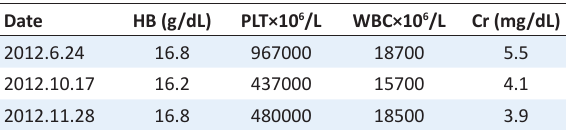
Table 1 . Laboratory tests before kidney transplantation